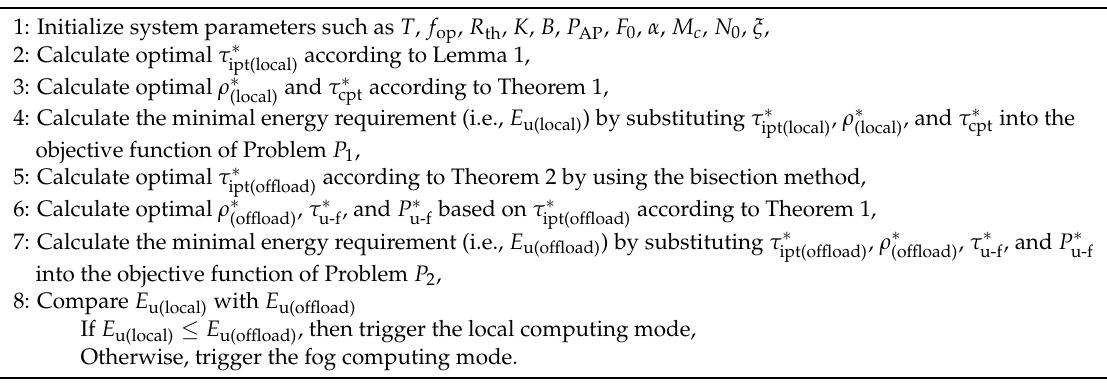
Algorithm 1. The optimal mode selection